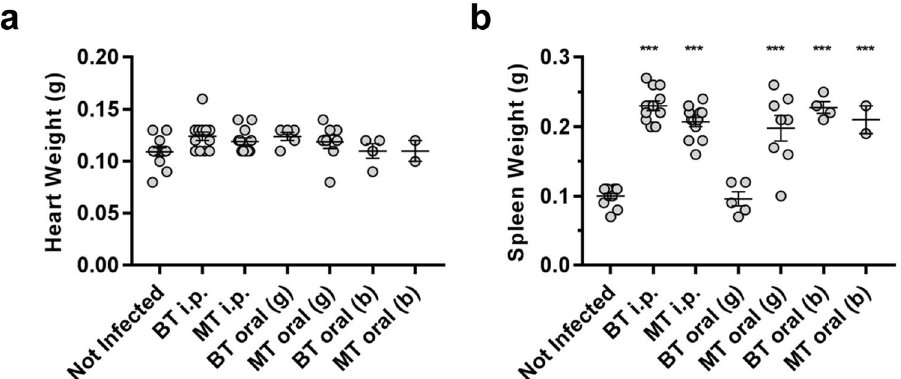
Figure 2. Heart and spleen weights in mice chronically infected with T. cruzi after oral transmission. Mice were infected with either metacyclic or bloodstream T. cruzi trypomastigotes (MT, BT) by i.p. injection, oral gavage (g) into the stomach or deposition in the oral cavity (b). Hearts ( a ) and spleens ( b ) from mice in which chronic infections were established were weighed at necropsy 4 months